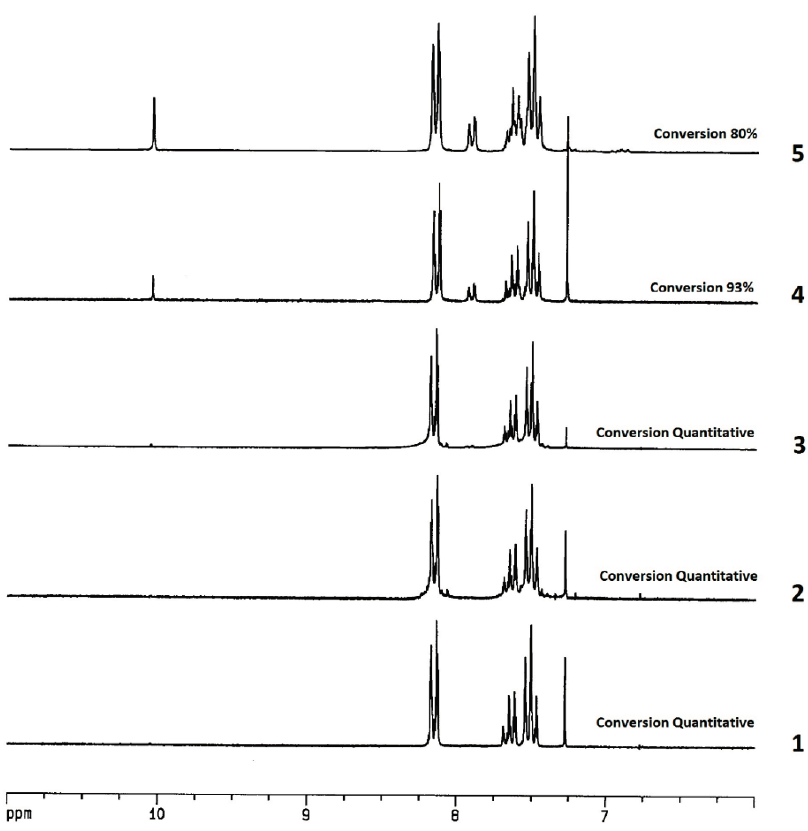
Figure 2. 1 H-NMR (200 MHz, CDCl 3 sol.) of the crudes obtained in the first 5 cycles of